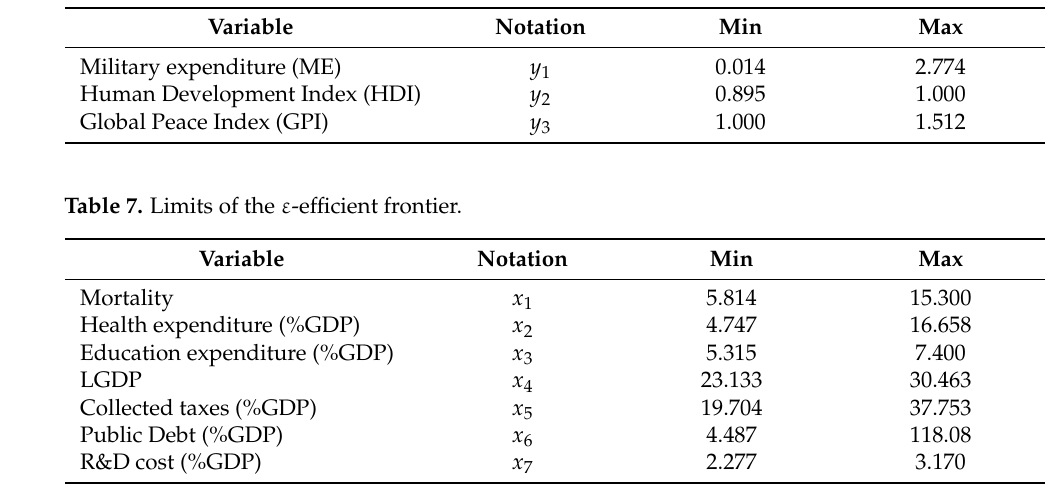
Table 6. Limits of the ε -Pareto front for the objective functions applied to NATO data from 27 countries.